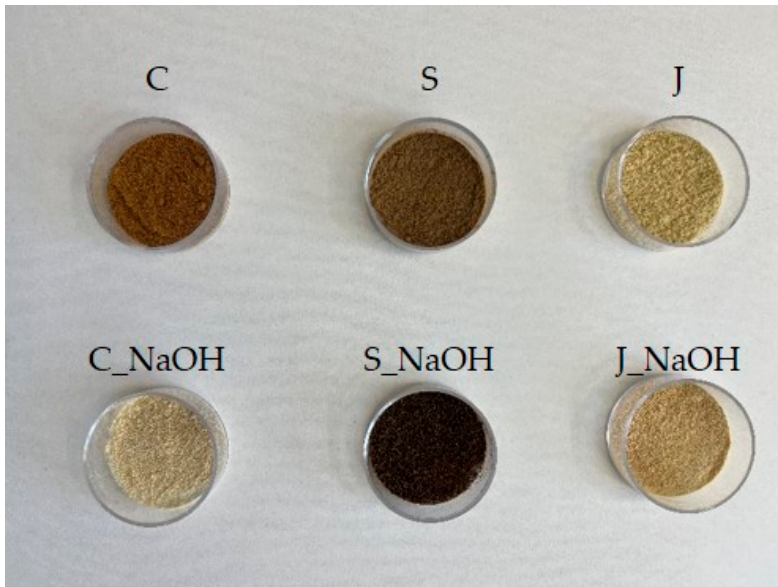
Figure 2. Oilseed cakes from Jatropha Curcas L. (filler) before and after alkaline surface